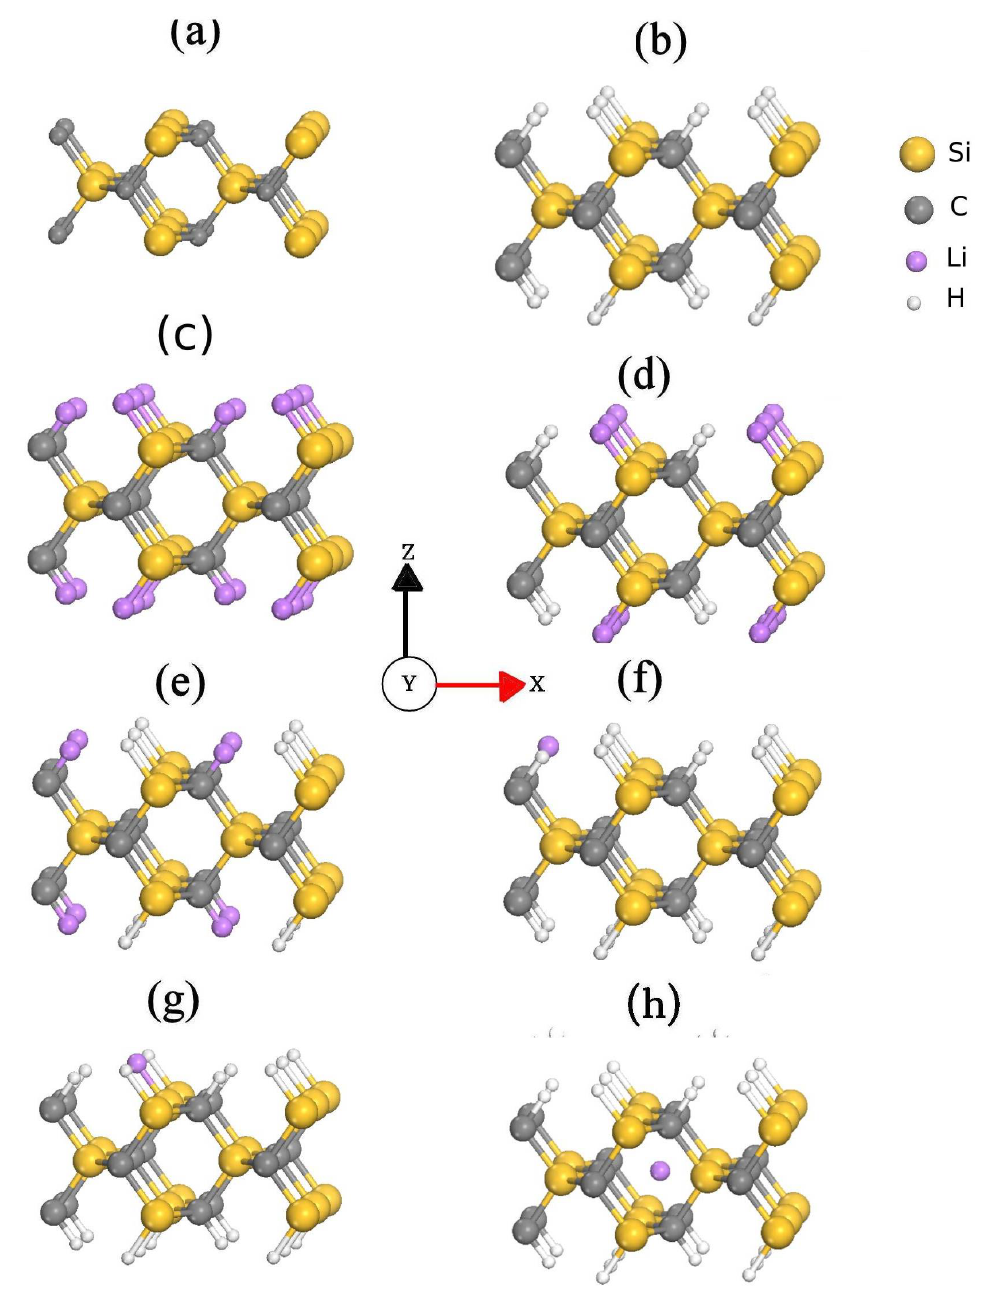
Figure 1. Schematic representation of 3C-SiC (1 1 0) monolayer with different passivations schemes: ( a ) Pristine; ( b ) Full-H; ( c ) Full-Li; ( d ) CH+SiLi; ( e ) CLi+SiH; ( f ) H+1LiC; ( g ) H+1LiSi; ( h ) H+Li c . The grey, yellow, white and purple spheres represent the C, Si,H and Li atoms,